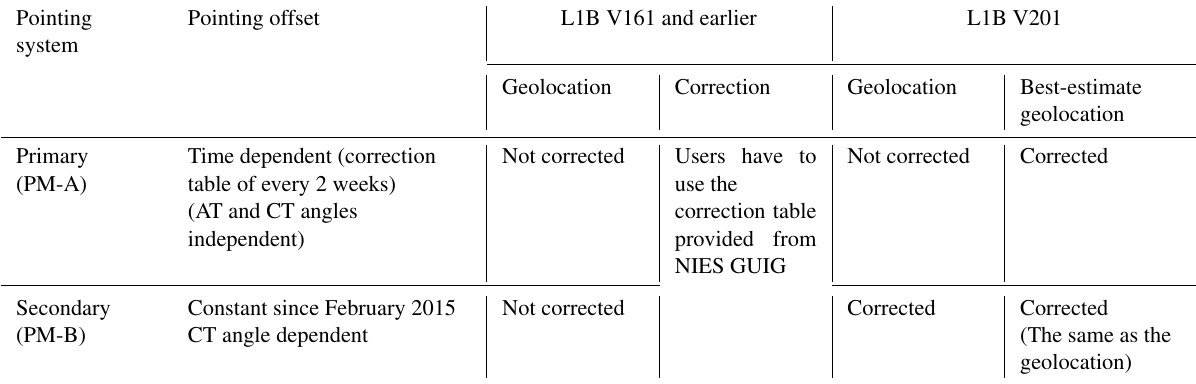
Table 1. Pointing offset and geolocation information in the L1B product. Pointing